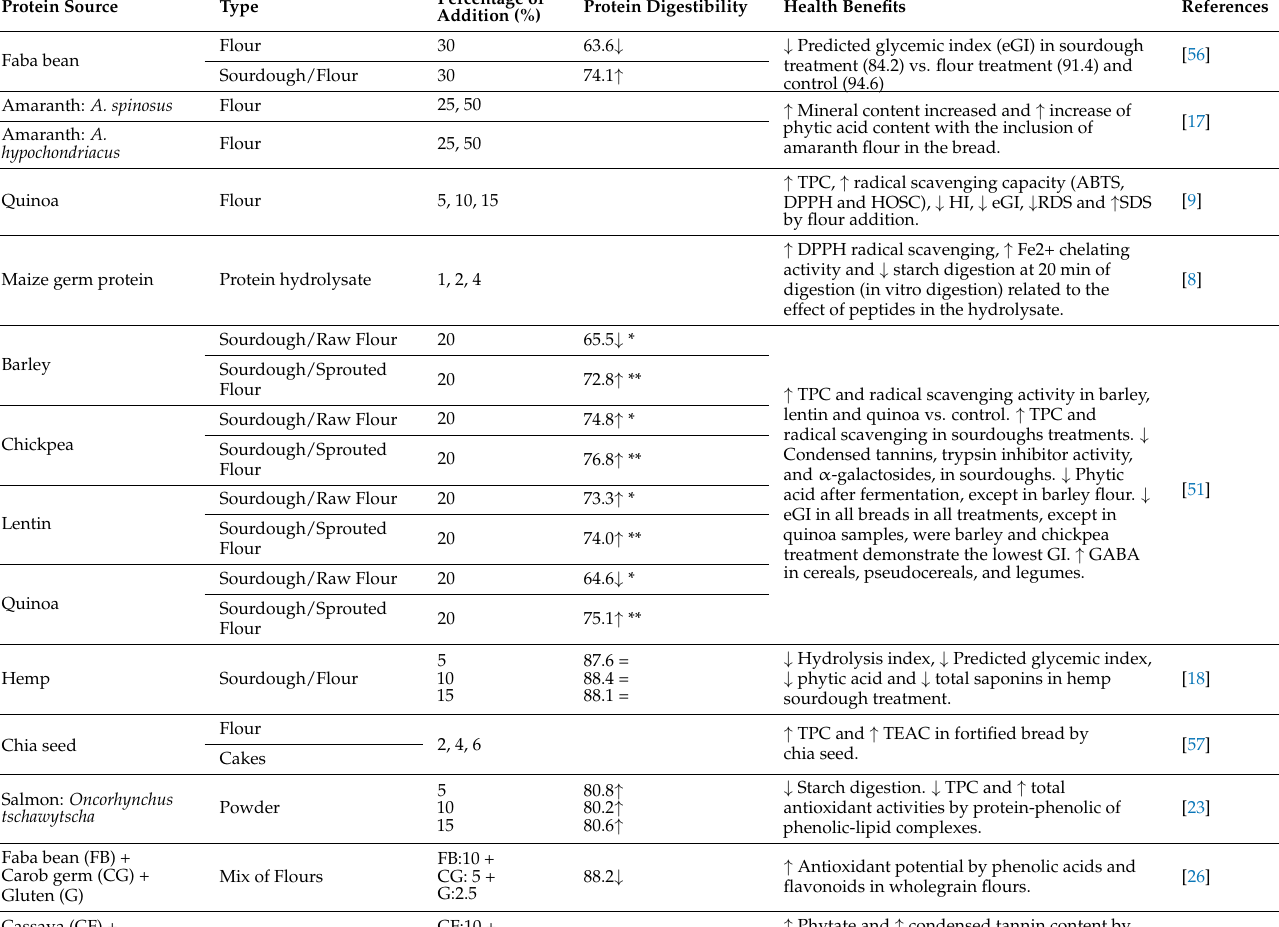
Table 4. Potential health benefits.